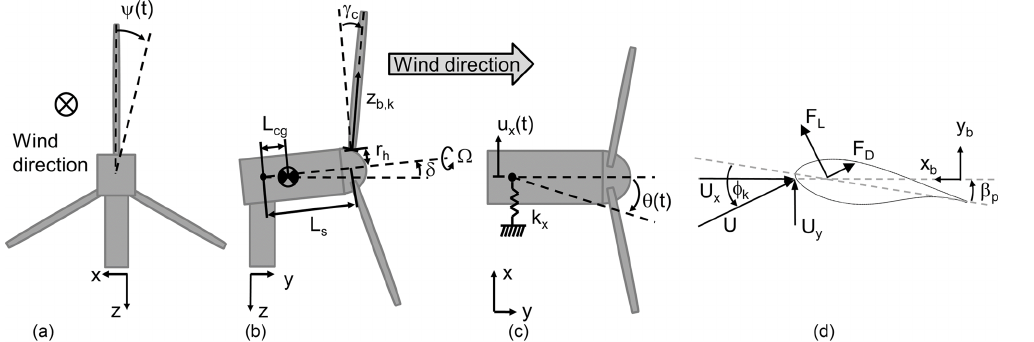
Figure 4. Schematics of turbine model and the according coordinate systems, front view (a) , side view (b) and top view (c) and the sketch (d) of the inflow and forces on the airfoil with the coordinate system.